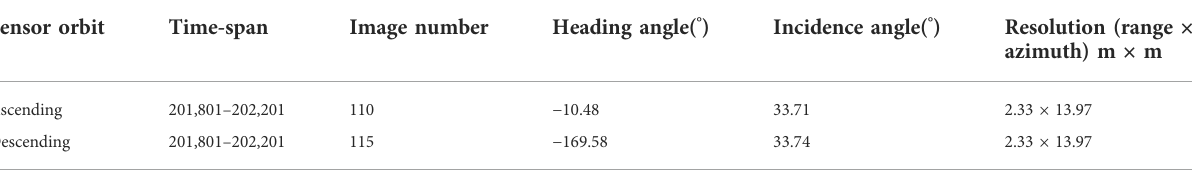
TABLE 1 Sentinel-1A datasets and primary image